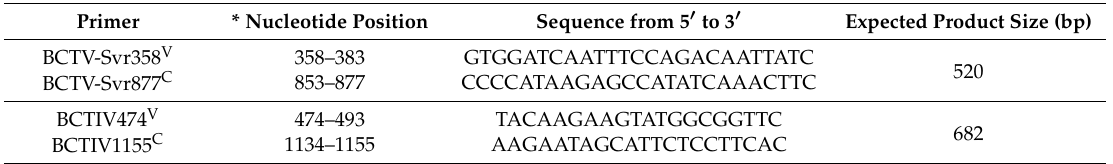
Table 1. Details of specific primers used in this